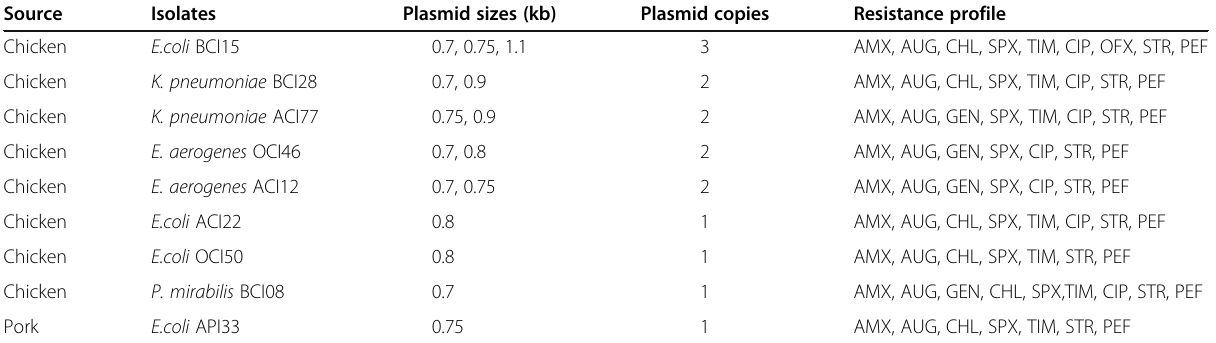
Table 3 Plasmid Profiles of 9 Enterobacteriaceae isolated from various meat sources Source